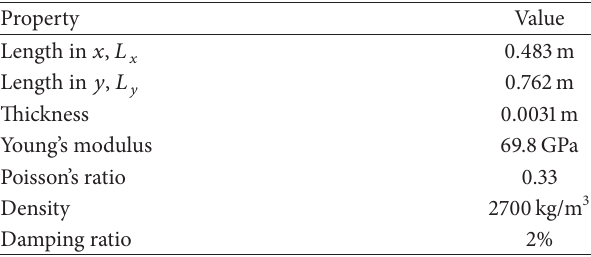
Table 2: Plate properties and dimensions for control simulations.